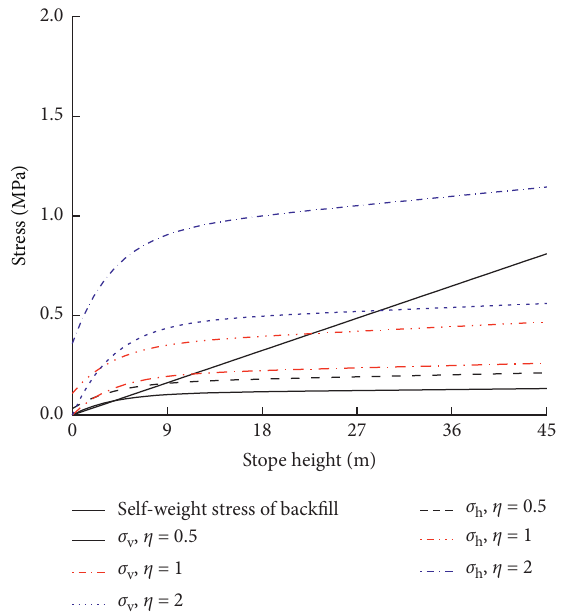
Figure 17: Effect of horizontal stress ratio on the time-dependent stress distribution of